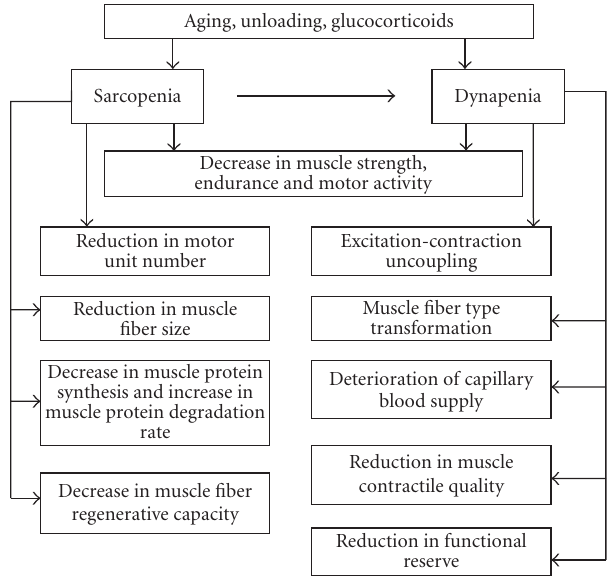
Figure 1: E ff ects of aging, unloading, and glucocorticoid treatment on skeletal muscle quantity and